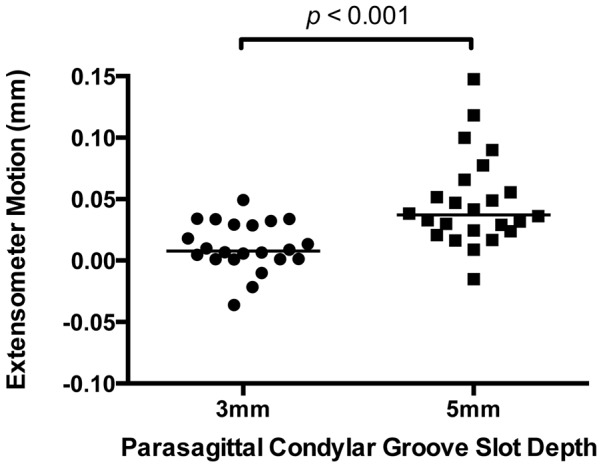
In our ex-vivo biomechanical model, extensometer micromotion associated with creation of shallow parasagittal slots in the palmar region of the condylar groove was used to model naturally occurring arrays of fatigue cracks.In both the 3-corrected extensometer motion was significantly different from zero (no motion) (p<0.001). Increased slot depth was associated with increased micromotion. In our model, the condyle was loaded at −7,500 N in compression. In the scatterplot, the horizontal bar represents the median value for each group.